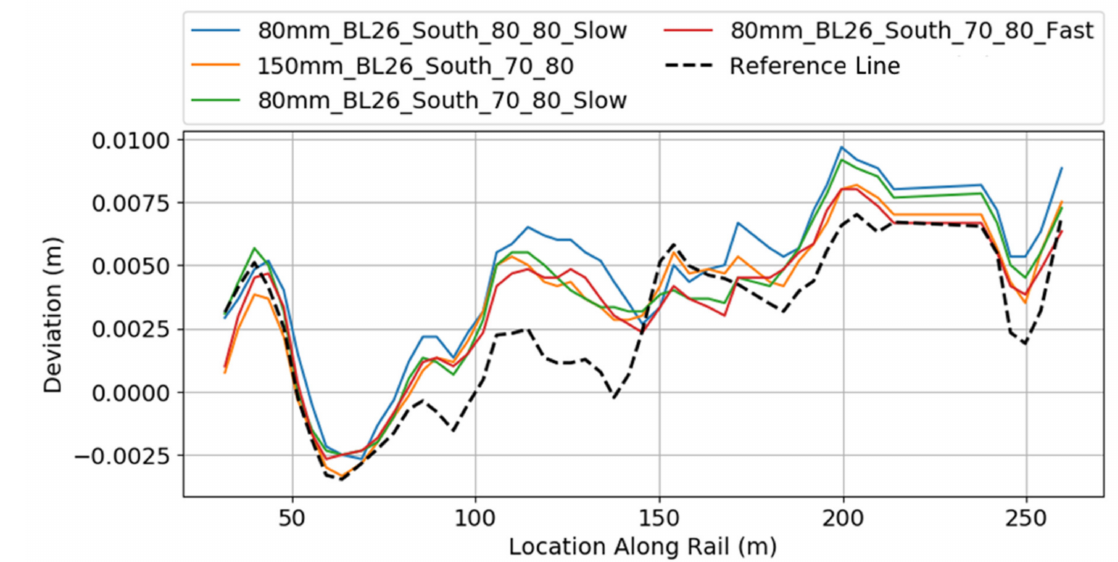
Figure 15. Deviation from the reference line along the reference axis using different flight and camera setup, continuous lines: our results, dashed line: reference